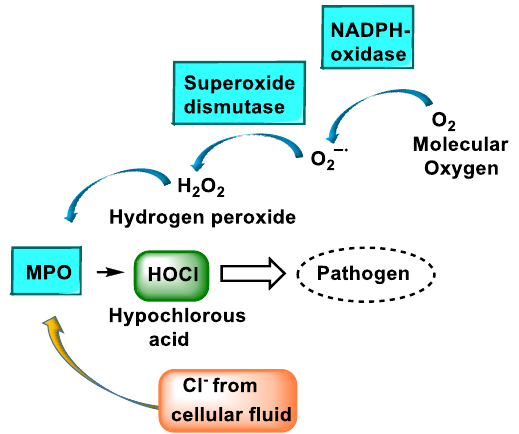
Figure 2. Schematic representation of HOCl production during the respiratory burst. The cell uses molecular oxygen (O 2 ) to produce H 2 O 2 , using the enzyme NADPH oxidase. MPO deposited on the azurophilic granules catalyses the reaction of H 2 O 2 and the chloride anion Cl − to form hypochlorous acid HOCl.